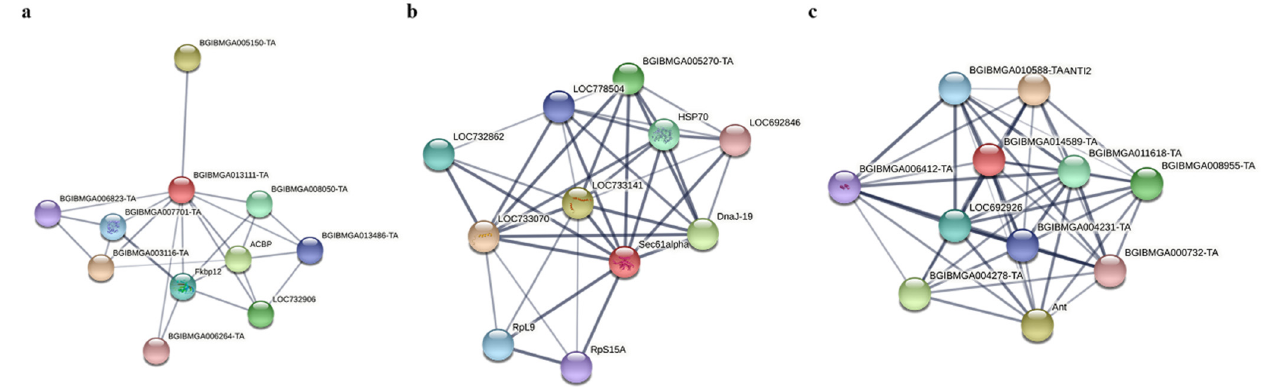
Figure 9. Protein–protein interaction (PPI) analysis of FABP1, PIC and SEC61. ( a ) FABP1. ( b ) SEC61. ( c ) PIC.